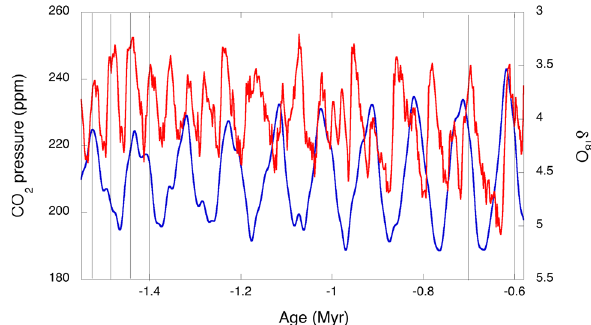
Figure 8. Mid-Pleistocene Transition. The benthic δ 18 O records of the LR04 stack (red) 7 are compared with the changes in CO 2 calculated with the Glaciator (blue). The vertical lines are separated by 42 kyr on the left and by 100 kyr on the